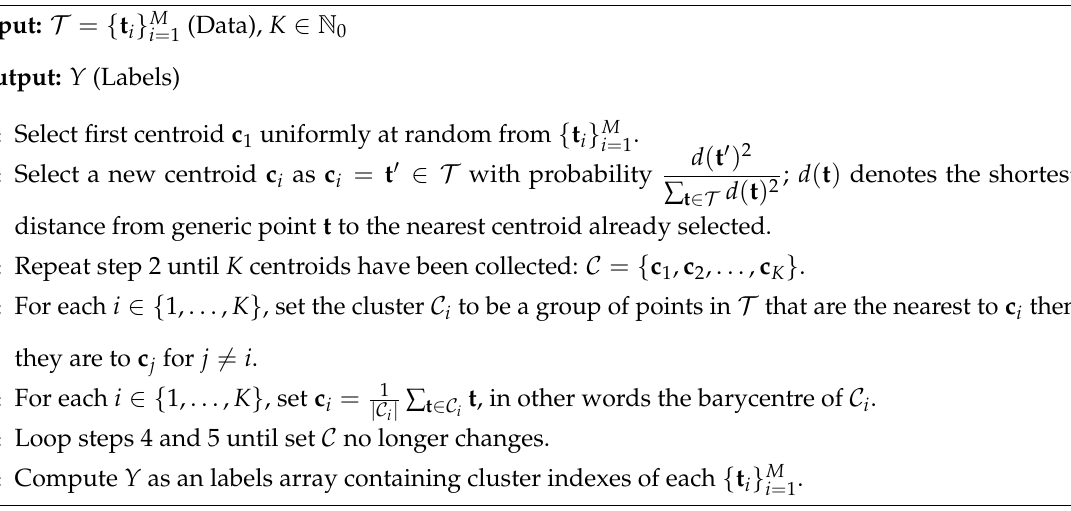
Algorithm 1 K -means ++ clustering with distance metric d (use Euclidean